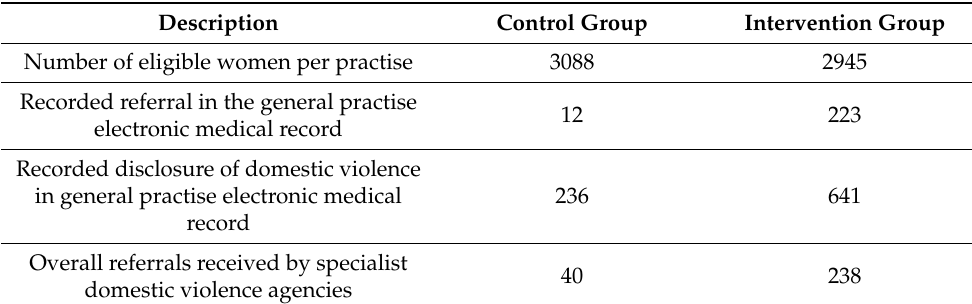
Table 1. Data from randomised controlled trial of